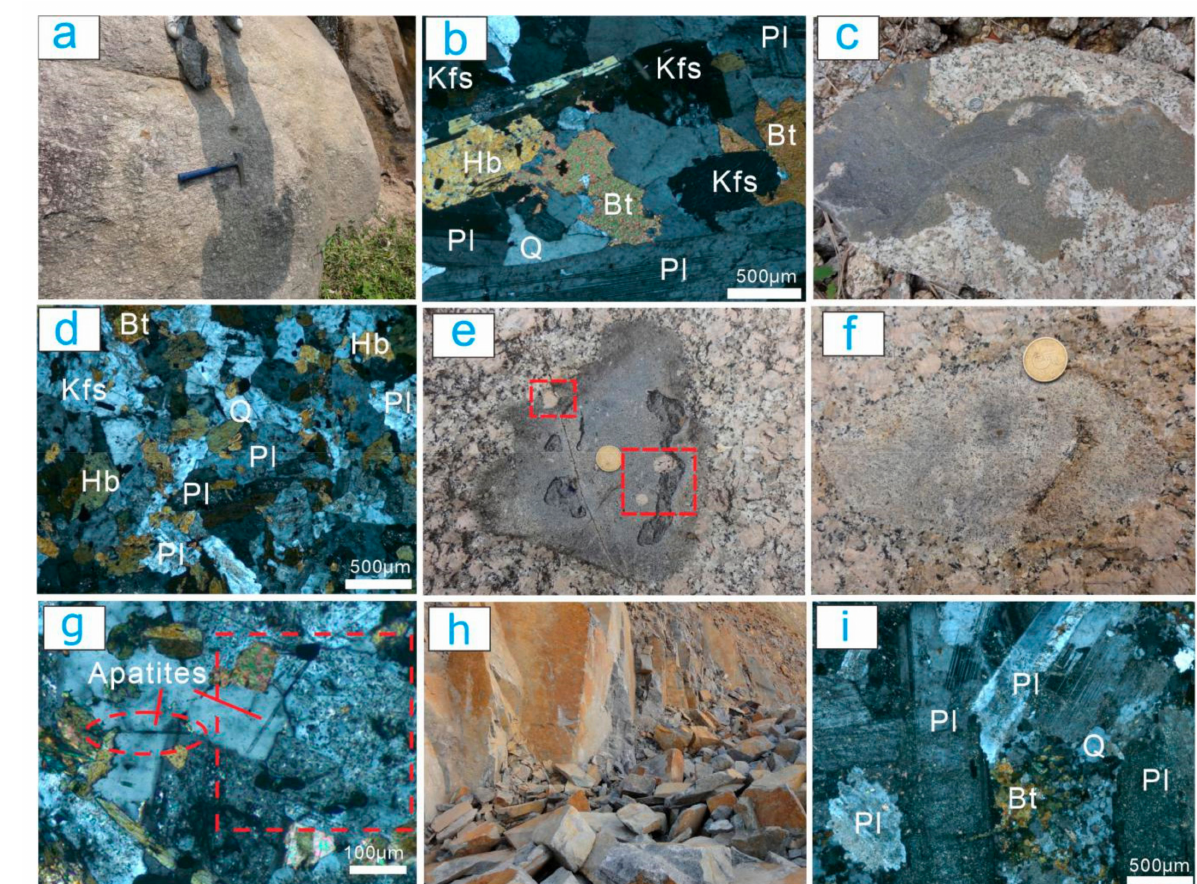
Figure 2. ( a ) An outcrop of the Xishan pluton. ( b ) Granite of the Xishan pluton under a microscope (cross-polarized light) with euhedral hornblende. ( c ) Flame-like mafic microgranular enclaves in the Xishan pluton. ( d ) Mafic microgranular enclaves in the Xishan pluton under a microscope (cross-polarized light), where dark minerals are biotite occurring as small and thin flakes, and light-colored minerals are euhedral columnar plagioclase and a small amount of columnar hornblende. ( e ) Mafic microgranular enclaves in the Xishan pluton and potassium-feldspar phenocrysts traversing the boundaries between the enclaves and host rock; some elliptical phenocrysts are visible within the enclaves. ( f ) An outcrop of Xishan pluton; the contact between enclaves and host rock is either obscure or gradational. ( g ) Acicular apatites are developed in the mafic microgranular enclave under the microscope (cross-polarized light). ( h ) An outcrop of the Fenghuangling pluton. ( i ) Fenghuangling diorite under the microscope (cross-polarized light) with columnar plagioclase (Kfs: alkali feldspar; Pl: plagioclase; Bt: biotite; Hb: hornblende; Q: